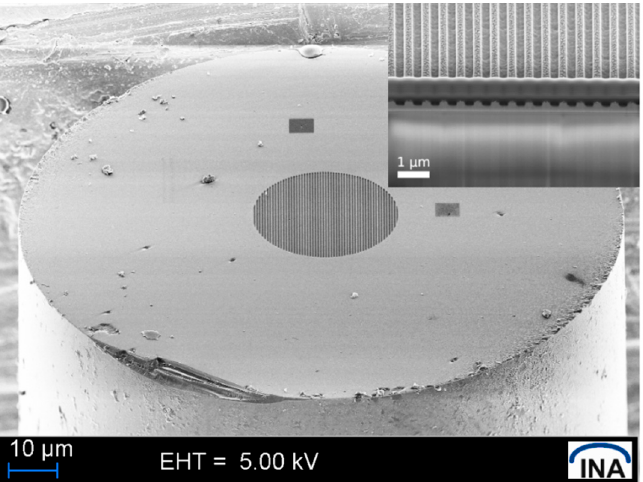
Figure 23. Tip of an optical fiber with GMR structure aligned to the core. The inset shows an FIB cross section of the ZrO 2 slab waveguide layer deposited by ion beam sputter deposition and the 1D periodic pattern fabricated by FIB milling. The dark bar covering a part of the pattern is a locally deposited protection layer to avoid damage of the pattern during preparation of the cross section and to enhance contrast for imaging.